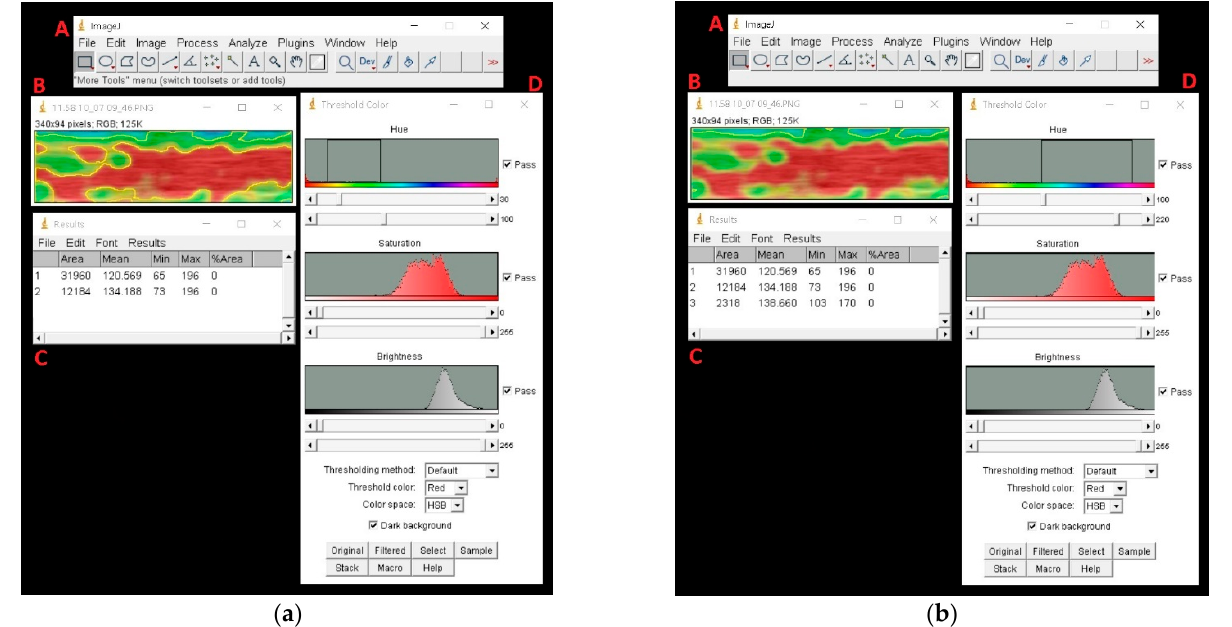
Figure 2. Example of analysis on ImageJ: ( a ) Selection of green area; ( b ) Selection of blue area. The selection of colors is mainly regulated with the Hue bar, and areas (expressed in pixels) of the selected part are measured. (A = ImageJ main tool bar, B = superficial digital flexor tendon elastogram image imported, C = Measurement results, D = “Threshold color” plugin).